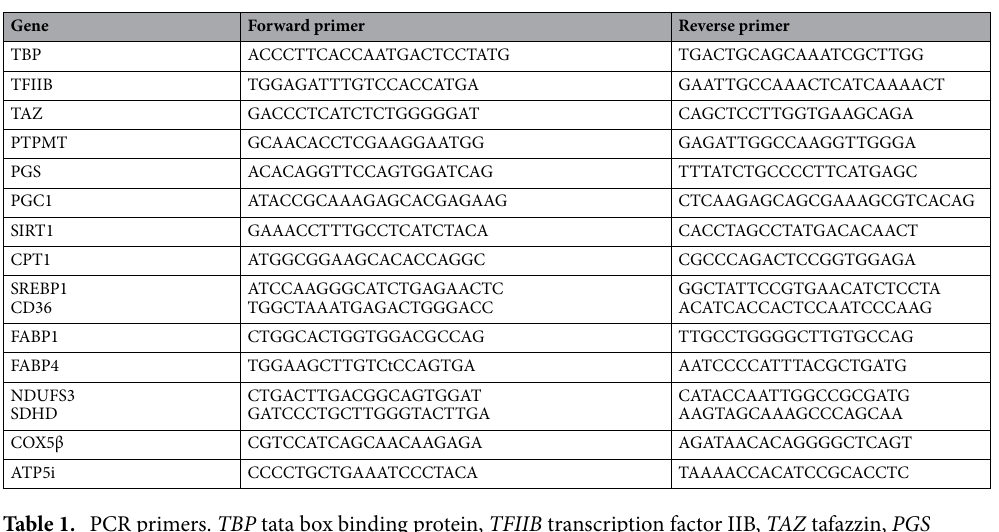
Table 1. PCR primers. TBP tata box binding protein, TFIIB transcription factor IIB, TAZ tafazzin, PGS phosphatidylglycerolphosphate synthase, PTPMT protein tyrosine phosphatase mitochondrial 1, PGC1α peroxisome proliferator-activated receptor gamma coactivator 1α, SIRT1 sirtuin 1, CPT1β carnitine palmitoyltransferase 1, SREBP1 sterol regulatory element-binding protein 1, ACOX1 acyl-CoA oxidase, FABP fatty acid binding protein, NDUF NADH dehydrogenase oxidoreductase core subunit S3, SDHD succinate dehydrogenase complex subunit D, COX5β cytochrome c oxidase subunit 5β, ATP5i ATP synthase subunit